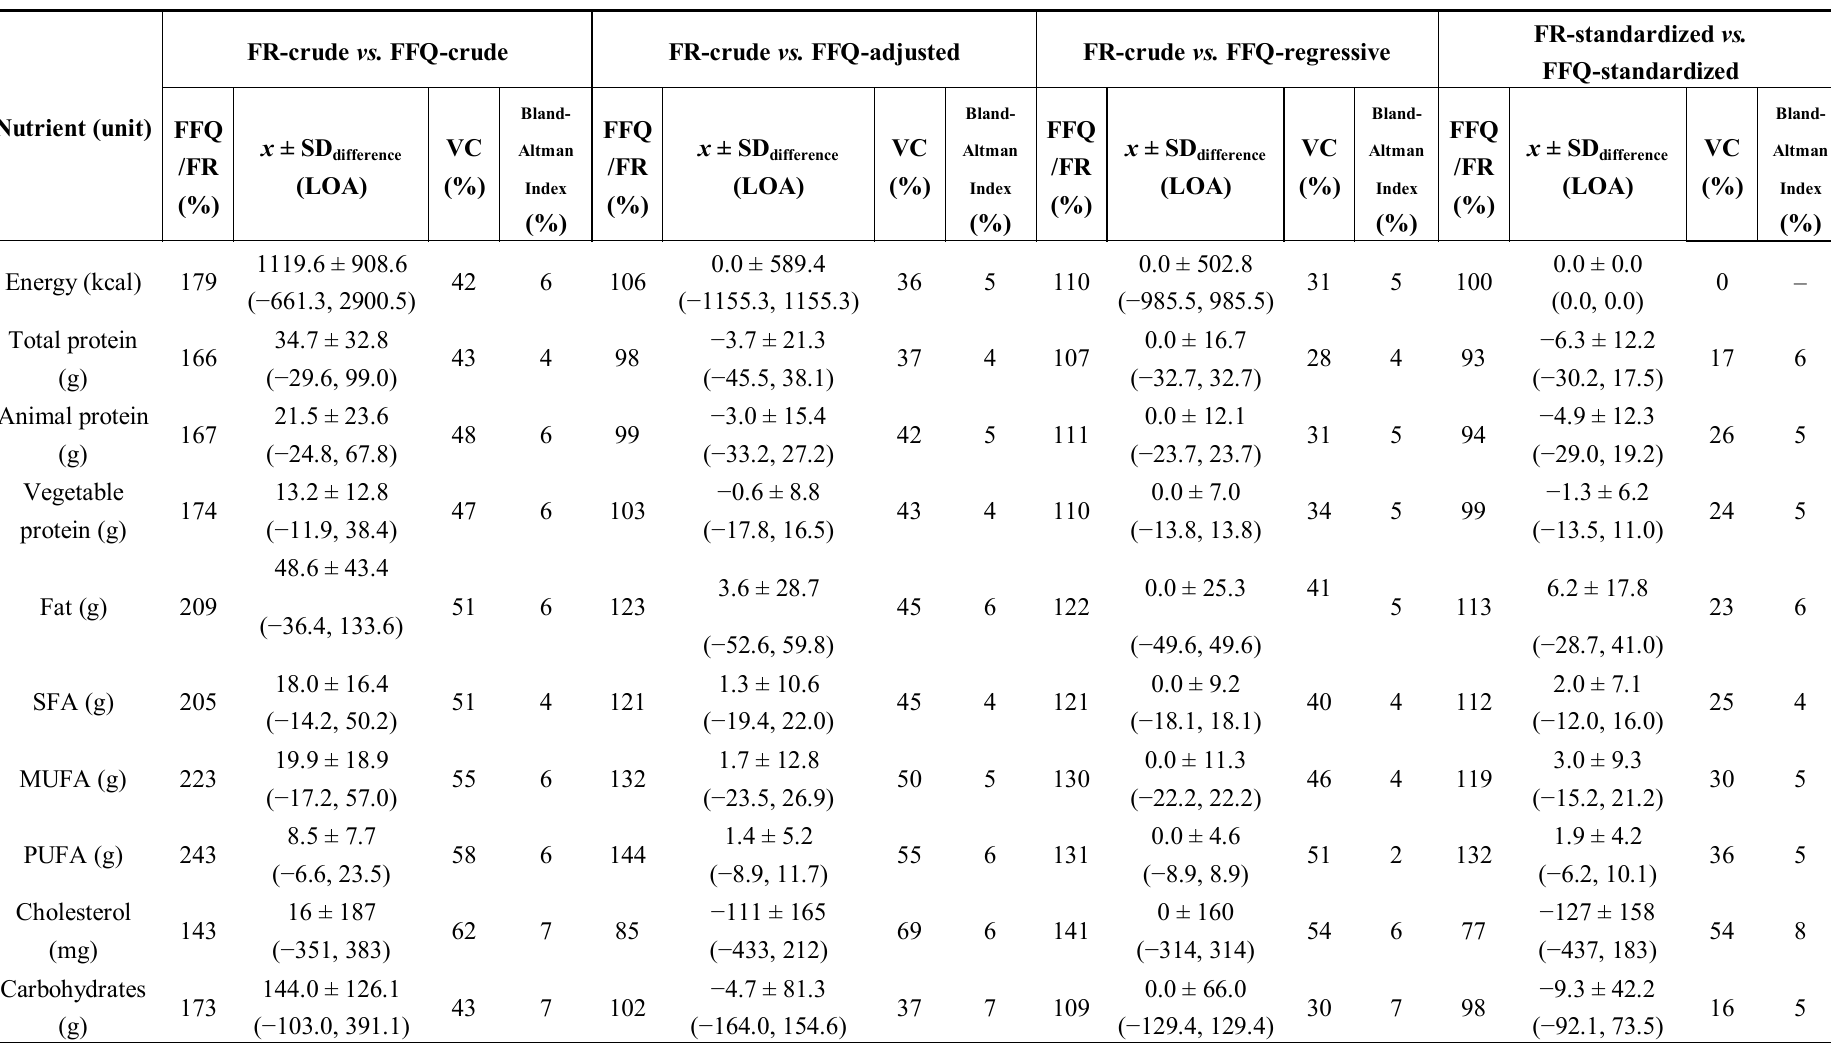
Table 3. Comparison of energy and nutrient intake in women ( n = 84) in the three-day unweighted food record (FR) and the food frequency questionnaire